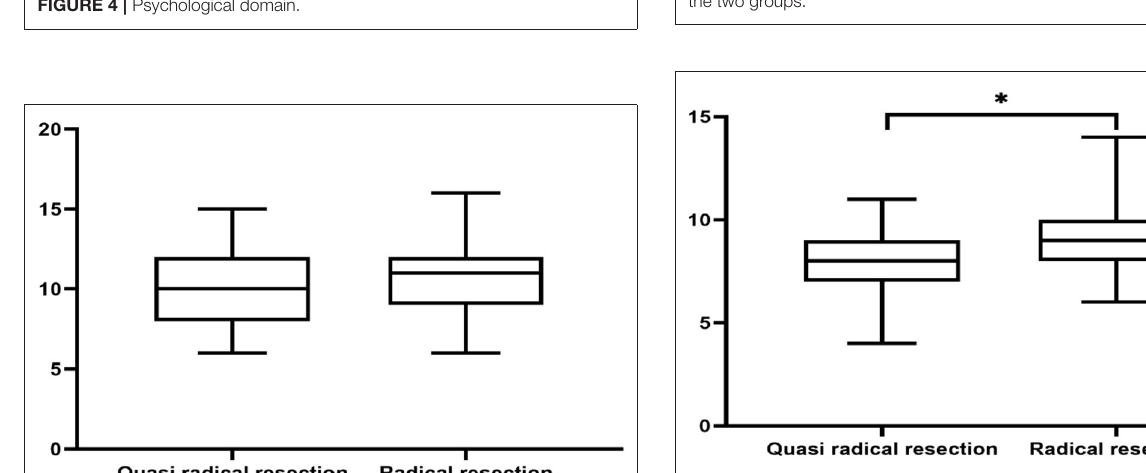
FIGURE 4 | Psychological domain.